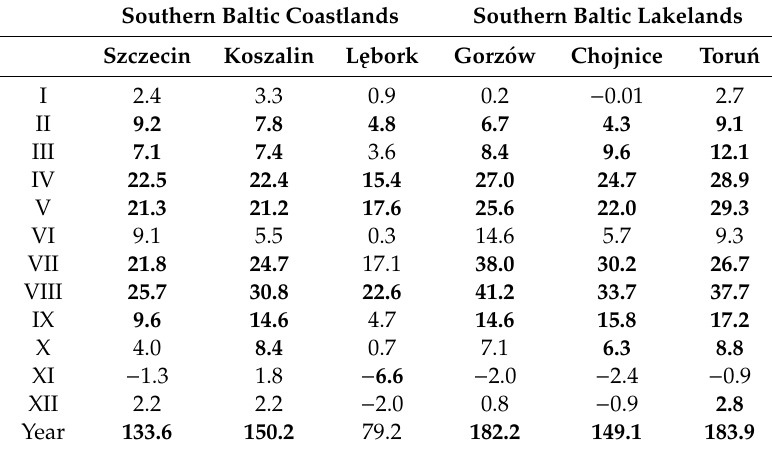
Table 7. Changes in monthly evaporation sums ( E 0 , mm) calculated from linear regression equations in the studied stations (1952–2018) (bold font indicates values that are statistically significant at a level of 0.05) ( E 0 calculated based on t and f and data obtained from the Polish Institute of Meteorology and Water Management—National Research Institute